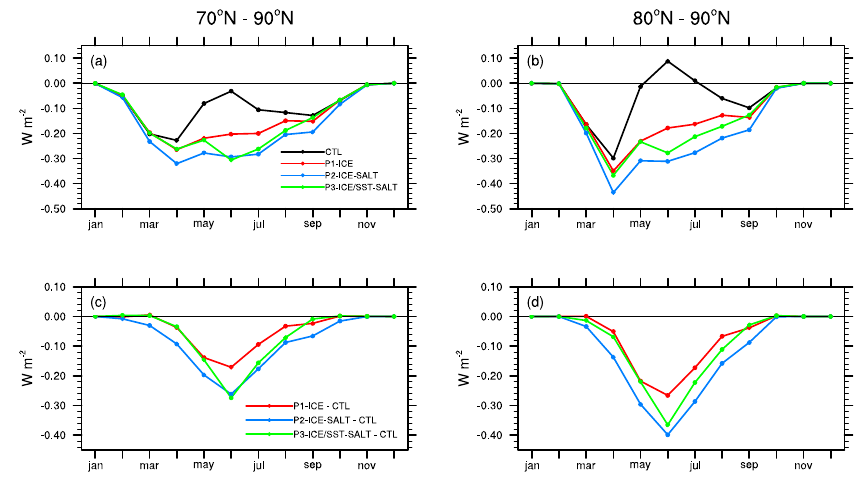
Fig. 12. (a) , (b) Modeled TOA aerosol direct radiative forcing in Wm − 2 attributed to natural aerosols. (c) , (d) differences in aerosol direct radiative forcing (relative to the CTL simulation). Averages are taken using all grid points for the final five years of the model integrations.